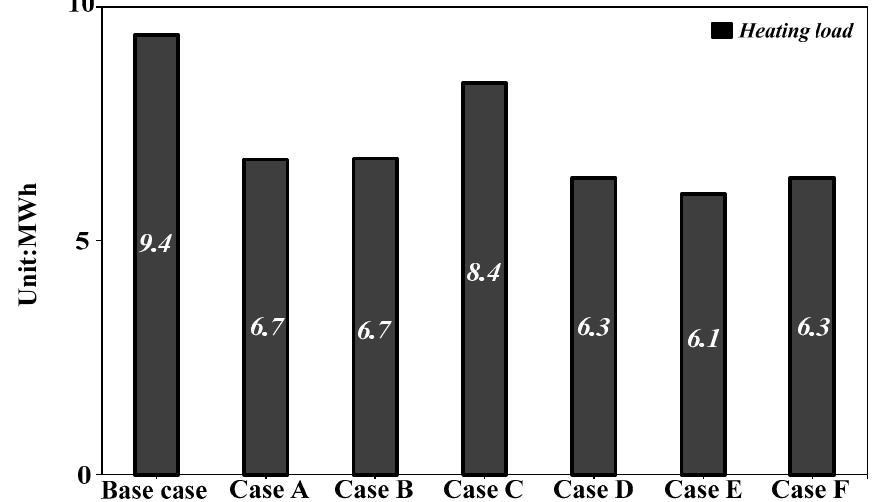
Figure 8. The comparisons of annual heating loads with the combinations of design alternatives.